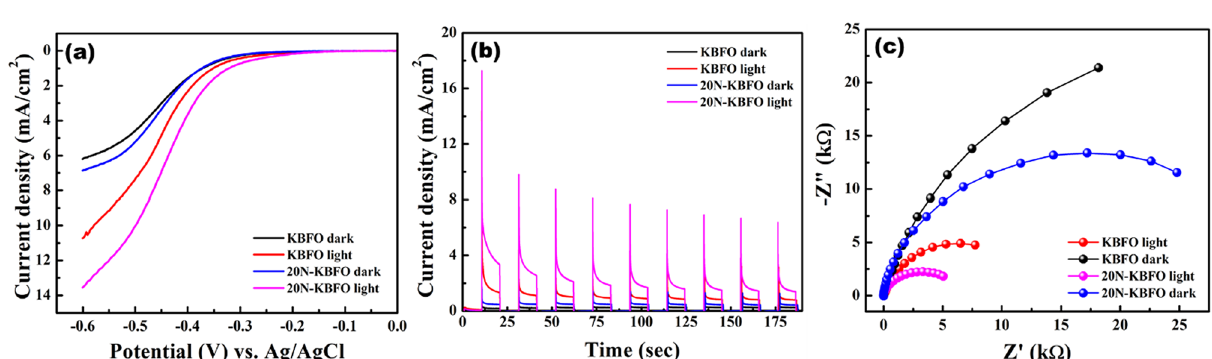
Figure 12. ( a ) I-V characteristics of KBFO and 20N-KBFO in dark and light illumination from LSV (0.6 V) ( b ) chronoamperometry curves of KBFO and 20N-KBFO in dark and light illumination ( c ) Photoelectrochemical impedance spectra of KBFO and 20N-KBFO in dark and light